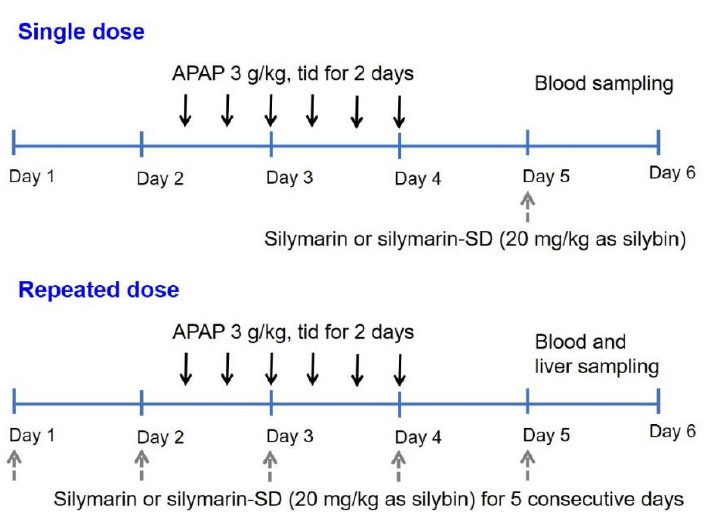
Figure 1. Dosing schedule for silymarin or silymarin-SD and APAP. Tid, three times per day. For single administration of silymarin or silymarin-SD, rats with APAP-induced hepatotoxicity received silymarin (20 mg/kg as silybin, n = 4) or silymarin-SD (20 mg/kg as silybin, suspended in 0.5% CMC, n = 4) via oral gavage 24 h after the last APAP administration. Blood samples were taken from the cannulated femoral artery at 0.25, 0.5, 1, 2, 4, 8, and 24 h after silymarin and silymarin-SD administration (Figure 1). Bloods were centrifuged at 16,000 × g for 1 min, and 50 µ L plasma stored at − 80 ◦ C for silybin